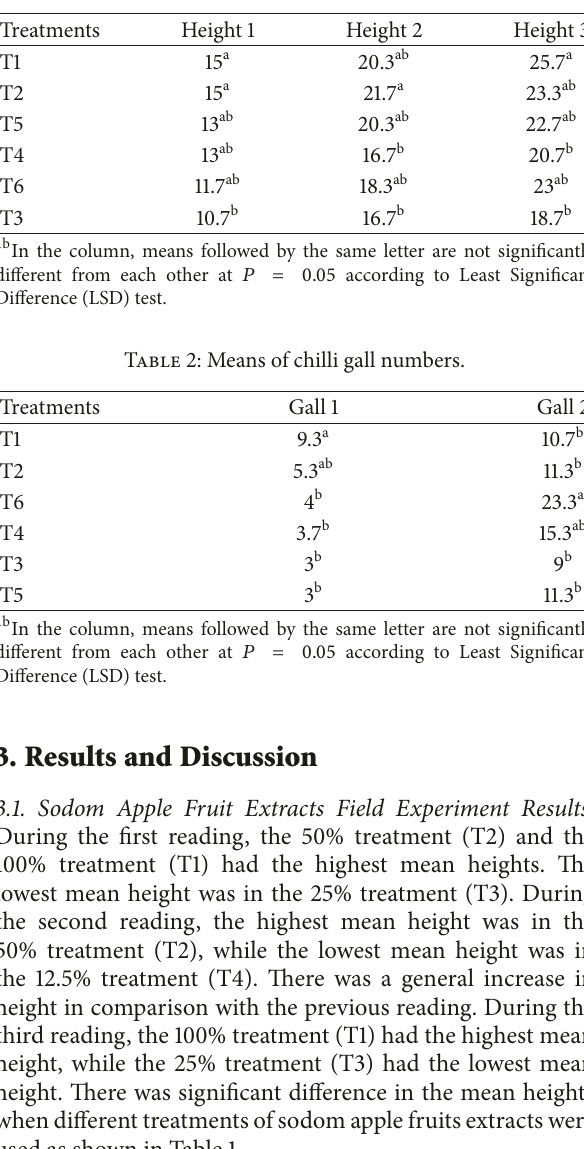
Table 1: Means of chilli heights.